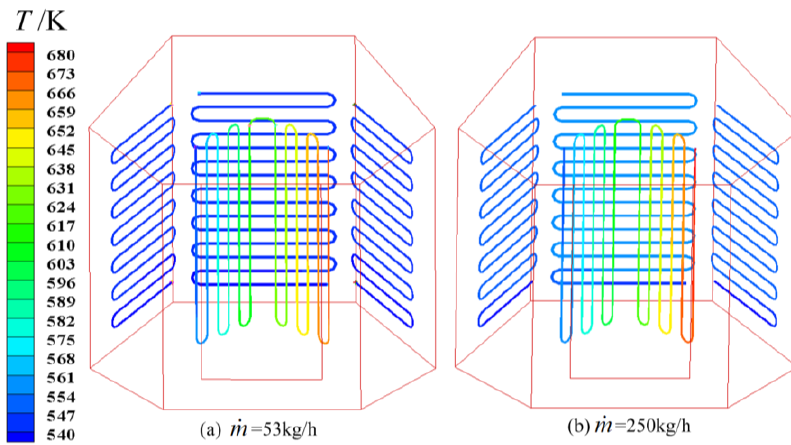
Figure 13. Distribution of the outer wall temperature of absorber